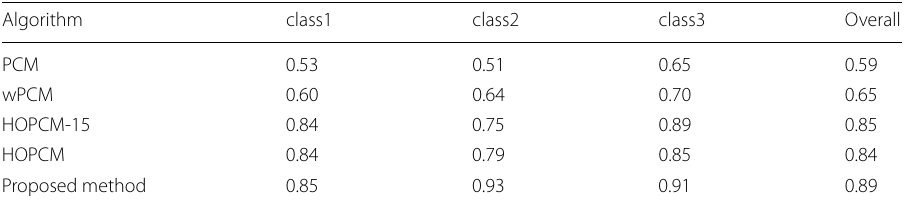
Table 4 Results of clustering quality on the Vehicle_sensIT dataset (ARI Score) Algorithm